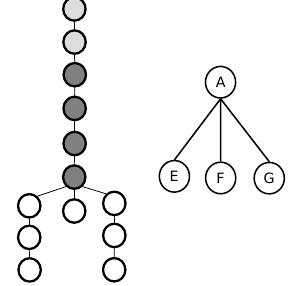
Figure 4: Contour tree and feature tree of Figures 1 and 2 after removal of feature C. Feature B has been removed because it is of the same class as feature A.